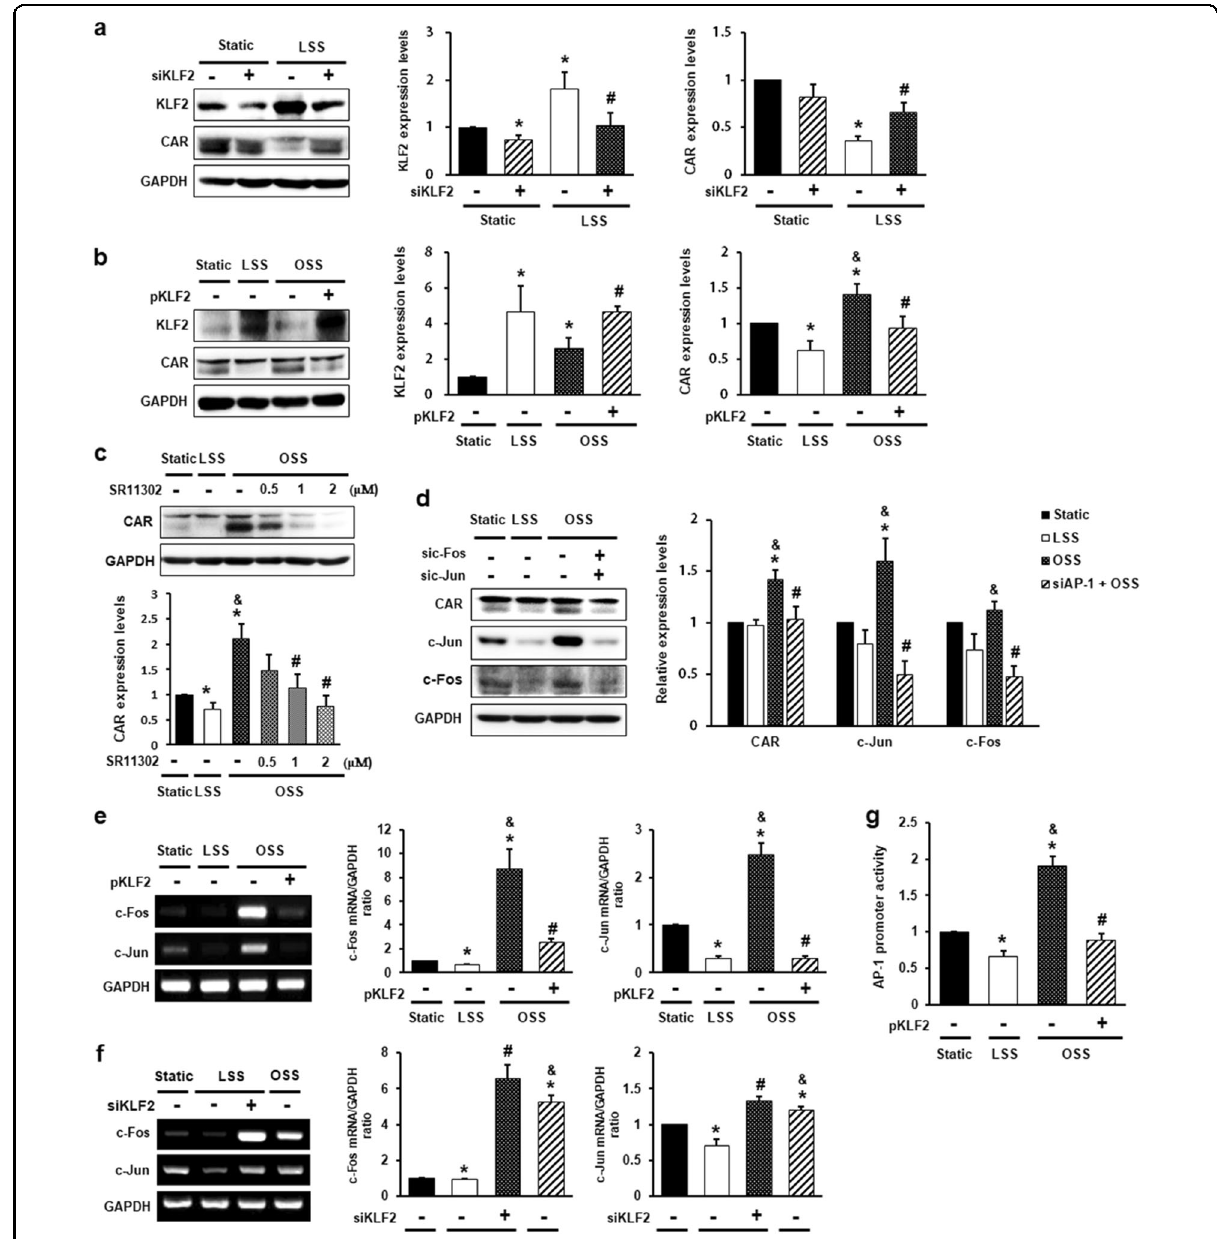
Fig. 2 CAR expression in endothelial cells is regulated by the fl ow-responsive KLF2-AP-1 axis. HUVECs were transfected with siRNA against Krüppel-like factor 2 (KLF2; 50 nM) ( a , f ) or plasmid-encoding KLF2 (5 μ g) ( b , e ) and then exposed to FSS for 4 h or 24 h. KLF2 and CAR protein levels were measured by western blotting. a n = 5; * P < 0.05, static vs. LSS; # P < 0.05, LSS vs. siKLF2 + LSS. b n = 5; * P < 0.05, static vs. LSS or OSS; & P < 0.05, LSS vs. OSS; # P < 0.05, OSS vs. pKLF2 + OSS. c HUVECs were exposed to FSS for 24 h after pretreatment with the AP-1 inhibitor SR11302 for 1 h. CAR protein levels were detected by western blotting ( n = 7; * P < 0.05, static vs. LSS or OSS; & P < 0.05, LSS vs. OSS; # P < 0.05, OSS vs. SR11302 + OSS). d HUVECs transfected with siRNAs against c-Fos (100 nM) and c-Jun (100 nM) were exposed to FSS for 24 h. The protein levels of CAR, c-Fos, and c-Jun were measured by western blotting ( n = 5; * P < 0.05, static vs. LSS or OSS; & P < 0.05, LSS vs. OSS; # P < 0.05, OSS vs. siAP-1 + OSS). e , f Transfected HUVECs were exposed to FSS for 4 h. Levels of mRNAs encoding AP-1 components (c-Jun and c-Fos) and GAPDH were measured by RT-PCR. e n = 4; * P < 0.05, static vs. LSS or OSS; & P < 0.05, LSS vs. OSS; # P < 0.05, OSS vs. pKLF2 + OSS. f n = 4; * P < 0.05, static vs. LSS or OSS; & P < 0.05, LSS vs. OSS; # P < 0.05, LSS vs. siKLF2 + LSS. g AP-1 promoter activity was measured by luciferase reporter assay ( n = 5; * P < 0.05, static vs. LSS or OSS; & P < 0.05, LSS vs. OSS; # P < 0.05, OSS vs. pKLF2 +